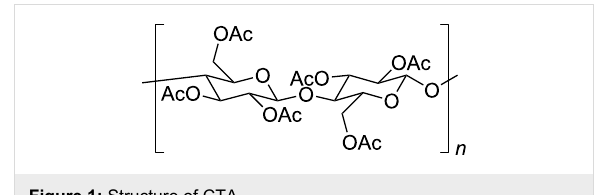
Figure 1: Structure of